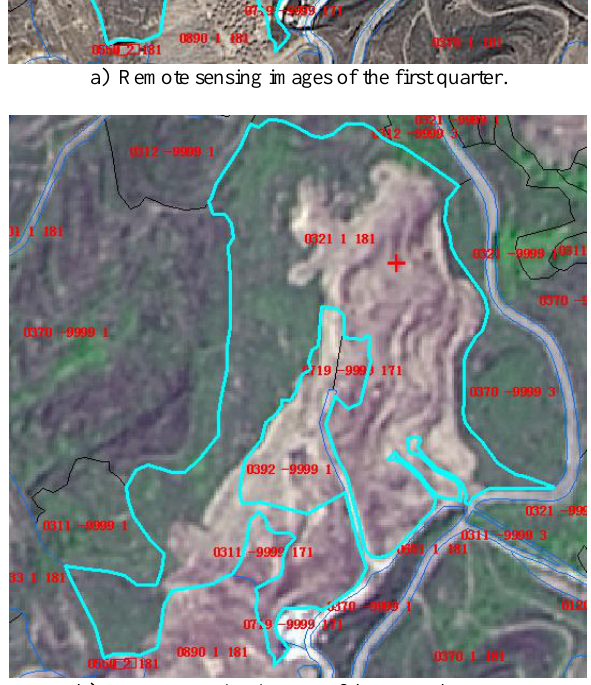
Figure 2. Remote sensing images without the latest time phase